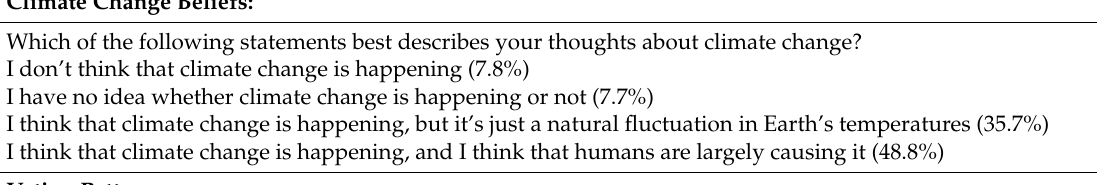
Table 2. Item wordings and descriptive statistics for climate change beliefs, voting pattern, hierarchical and individualistic views and opposition to gay